Question: Give a one-sentence summary of this figure.
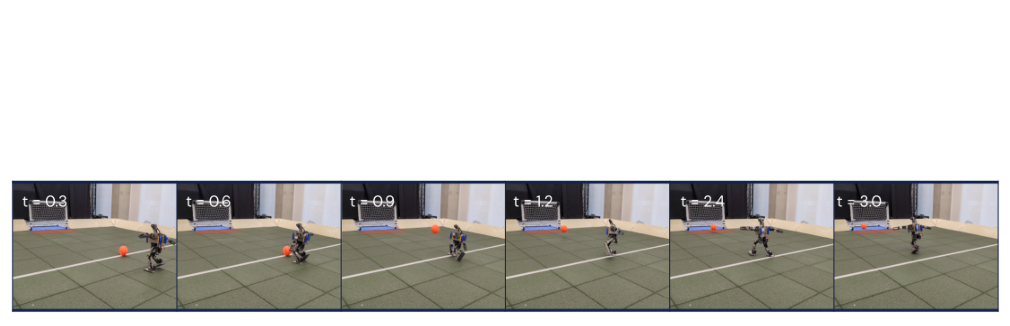
Answer: Shooting behavior, real-world: The agent smoothly transitions between skills and scores.